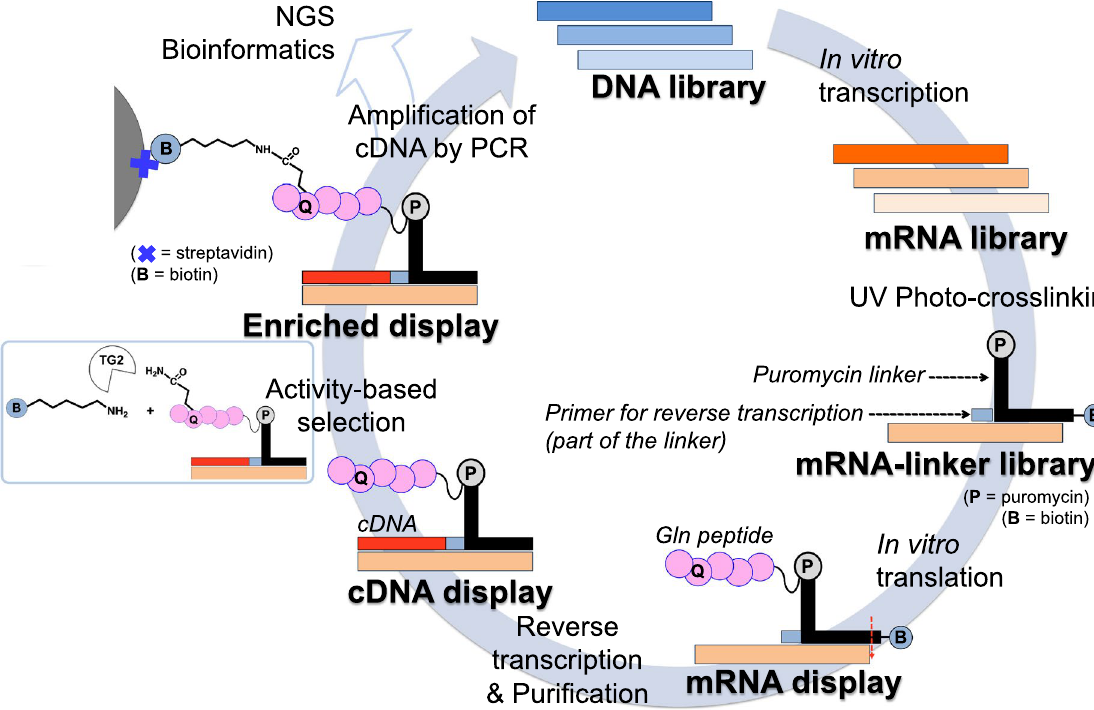
Figure 1. Outline of the cDNA display platform for screening and selection of preferred TG2 peptide substrate. TG2 stands for transglutaminase 2. Red dotted line represents cleavage site of RNase